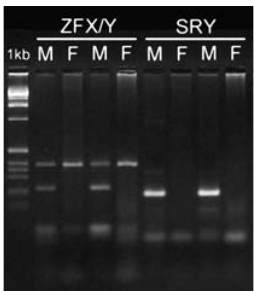
Figure 1 - Sex determination patterns for male (M) and female (F) Sotalia samples, using the Zfx/Zfy and Sry primer systems.